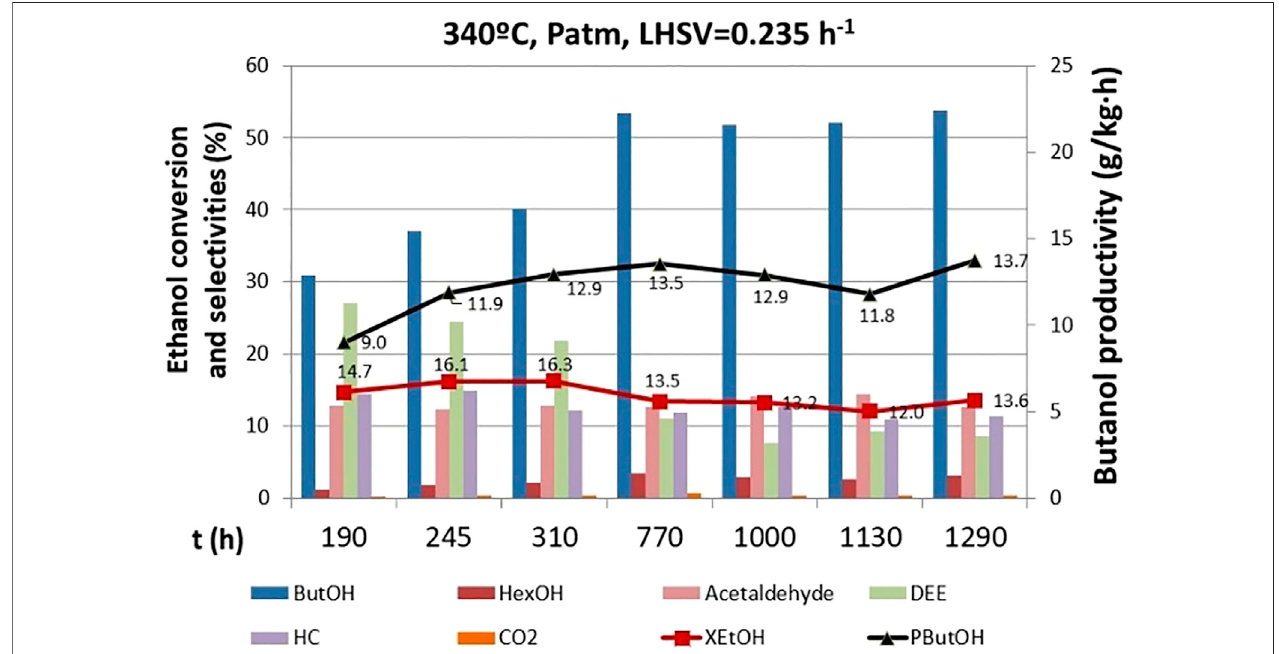
FIGURE 4 | Catalyst stability on time. ButOH = butanol; HexOH = hexanol; HC = hydrocarbons; DEE = diethyl ether.